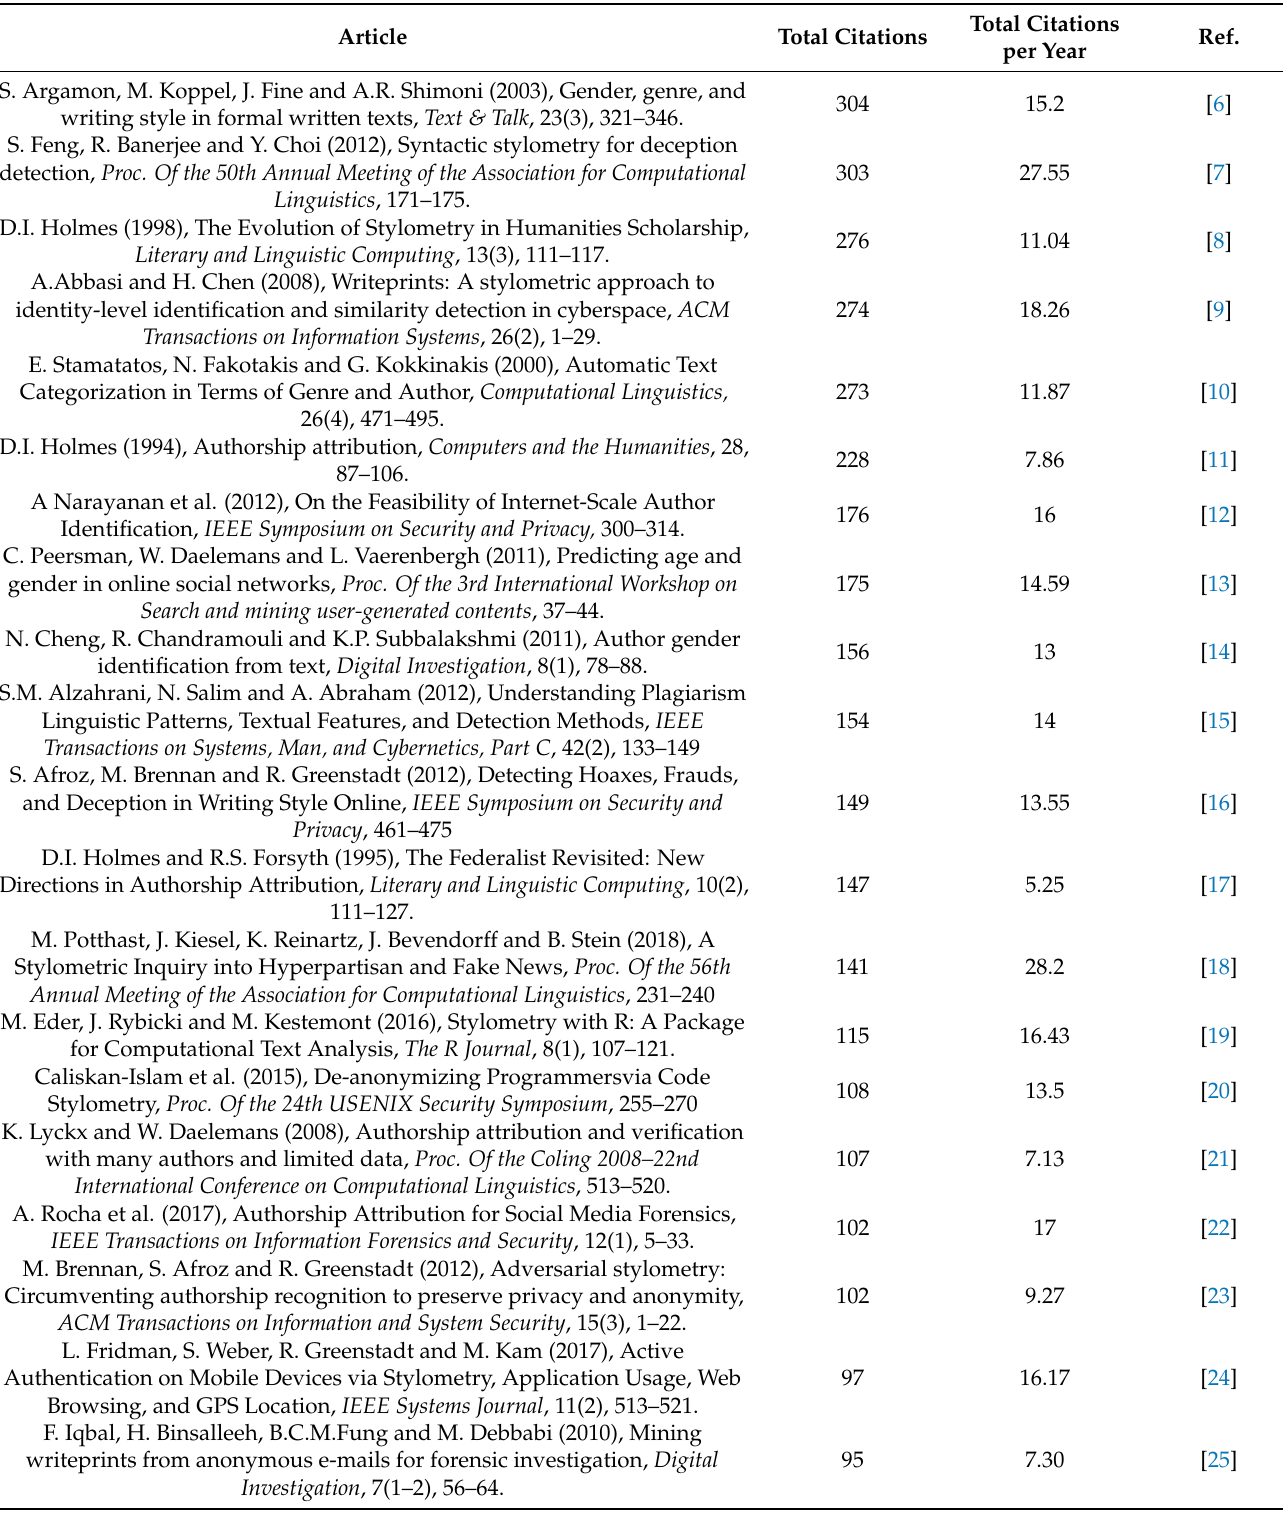
Table 4. Top 20 articles by total